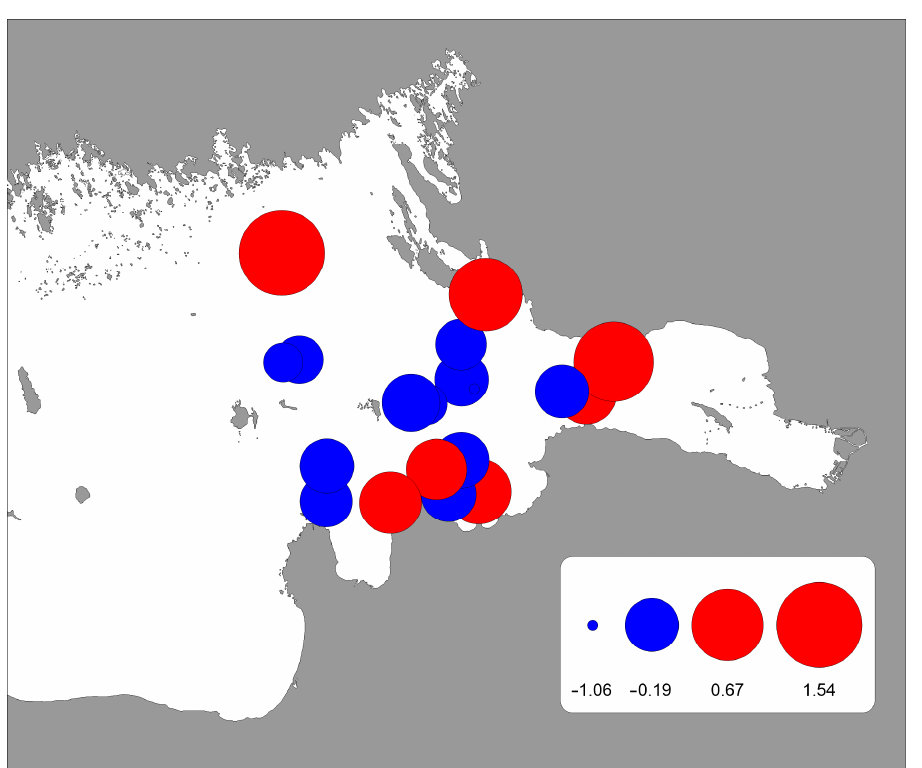
Figure 2. Water Pollution Index (WP) at sampling sites in the eastern Gulf of Finland. Blue and red cycles denote, respectively, negative and positive anomalies of this index.